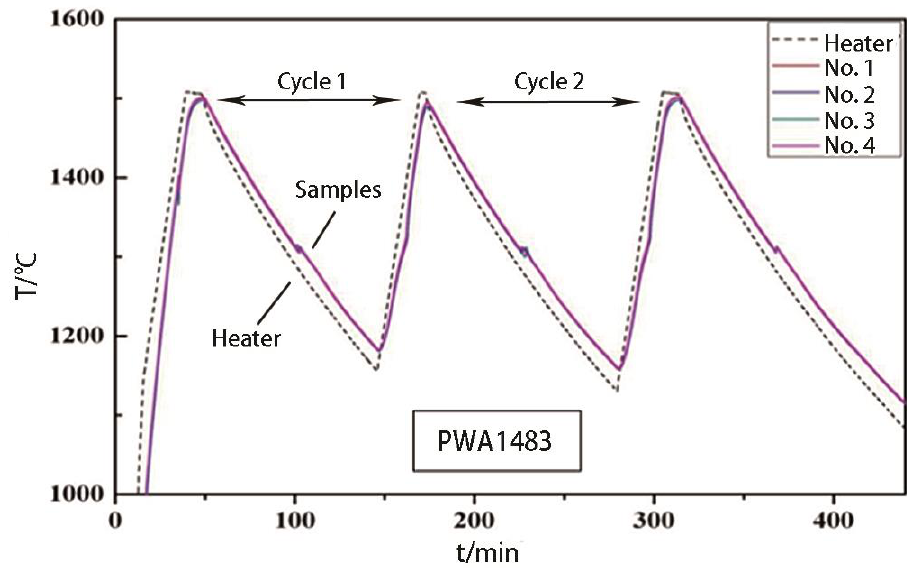
Figure 3. The measured temperature curves of the heater and four PWA1483 samples (No. 1 to No. 4) in the undercooling experiment.